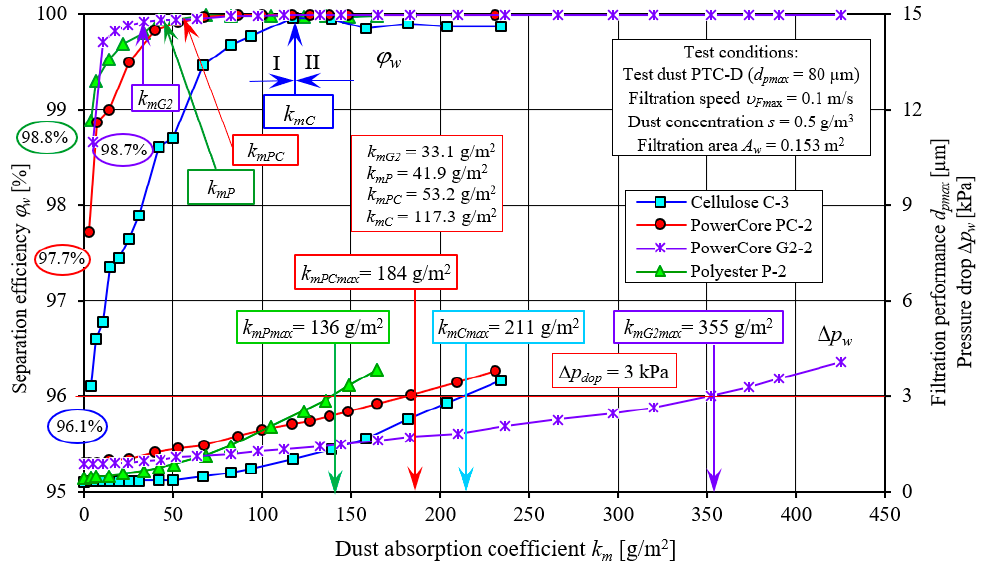
Figure 23. Characteristics of separation efficiency ( φ w ) and pressure drop depending on the dust absorption coefficient ( k m ) of the tested PC, G2, C and P filter